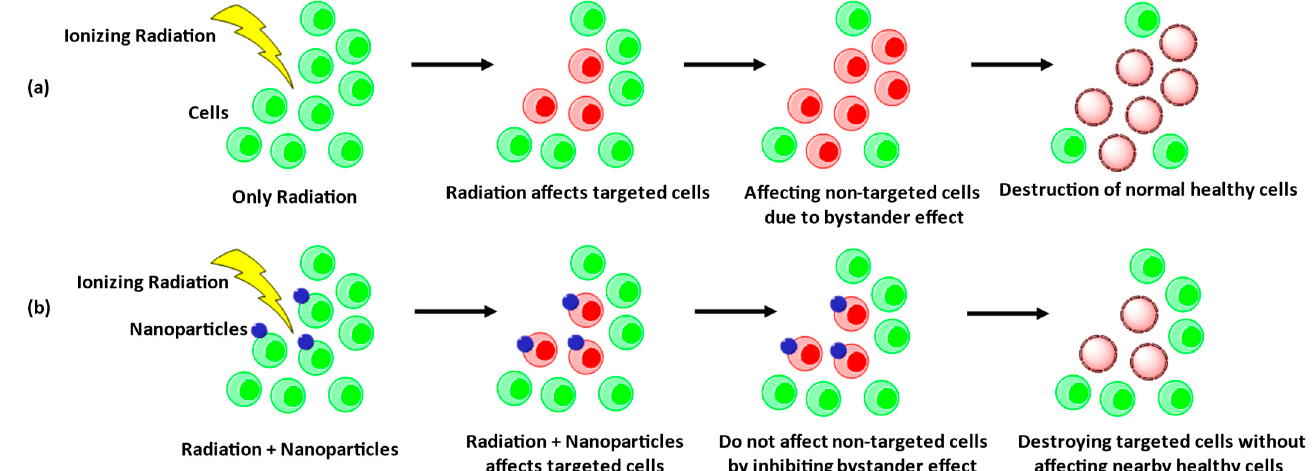
Figure 3. Radiation-induced bystander effects. ( a ) Irradiating cancer cells causes both targeted and non-targeted cell destructions. ( b ) Radiation along with NPs only kills tumor tissues, leaving the nearby healthy cells intact.